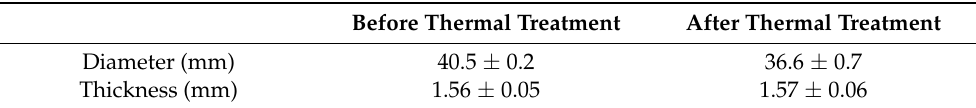
Table 2. Summary of the average dimensions of the produced TiC samples before and after the thermal treatment.